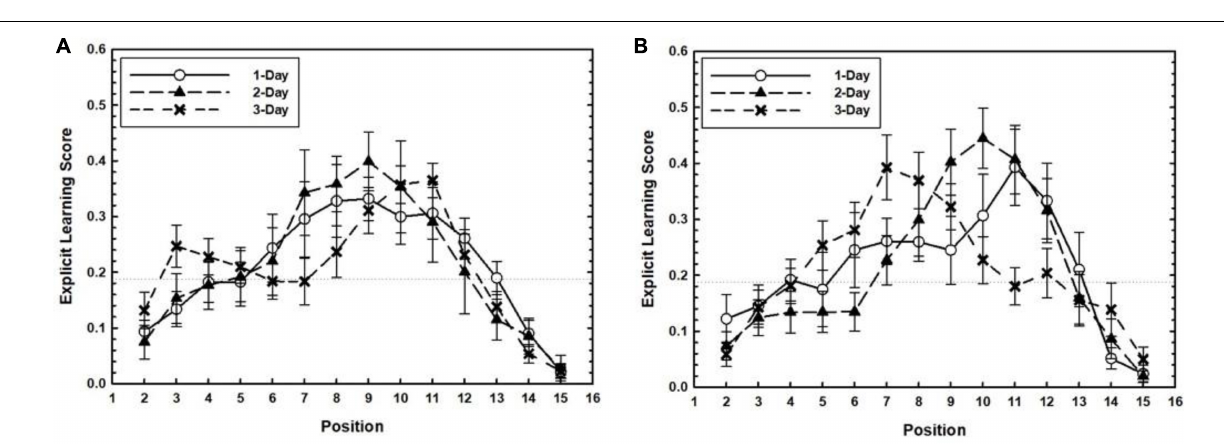
p s > 0.25. Taken together, these results did not show strong support for the emergence of explicit knowledge of practiced target positions during the training phase, although limited evidence for explicit learning of a subset of target positions could be